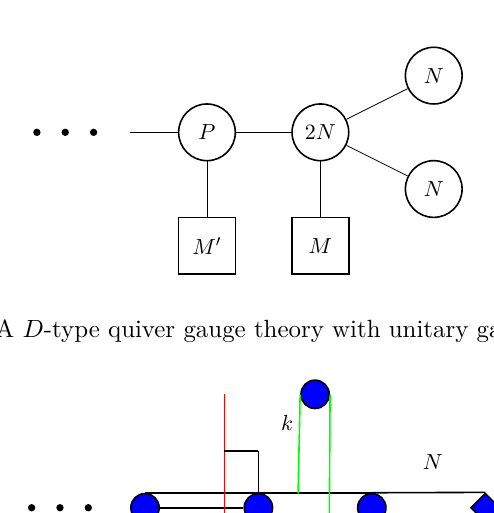
D1-branes 1 , . . . , k N